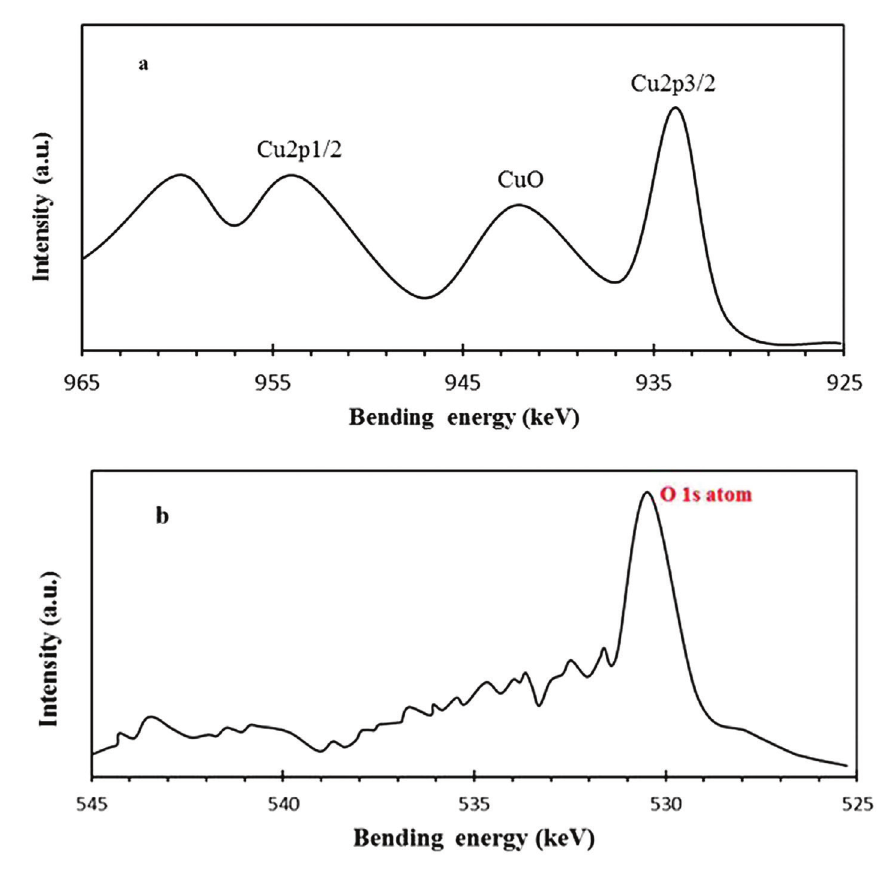
Figure 4: XPS spectra of wheat-mediated CuO NPs, (a) Cu 2P and (b) O